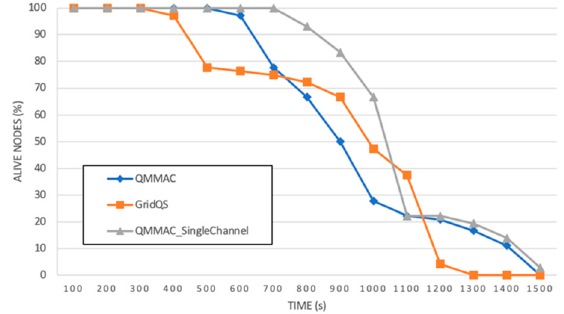
Figure 18. Alive Figure 18. Alive Nodes.